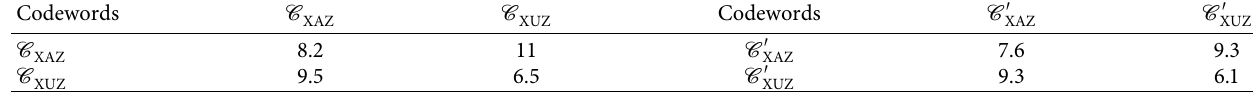
Table 6: Hamming distance between hydrophobic and hydrophilic Amino